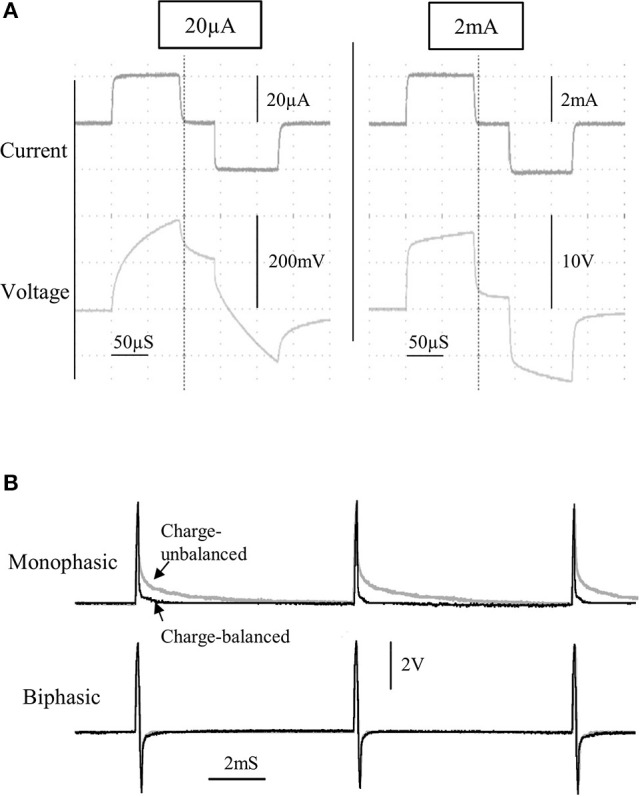
The current and voltage of the stimulus pulses was observed for a wide range of currents, from 20 to 2,000 μA, for a bipolar stimulating electrode immersed in saline (A). A comparison between charge-balanced (black) and charge un-balanced (gray) monophasic/biphasic voltage waveforms is shown using 200 μA pulses (B). Note that passive charge balancing is more noticeable with monophasic pulses, due to the increased charge build-up that would otherwise occur.